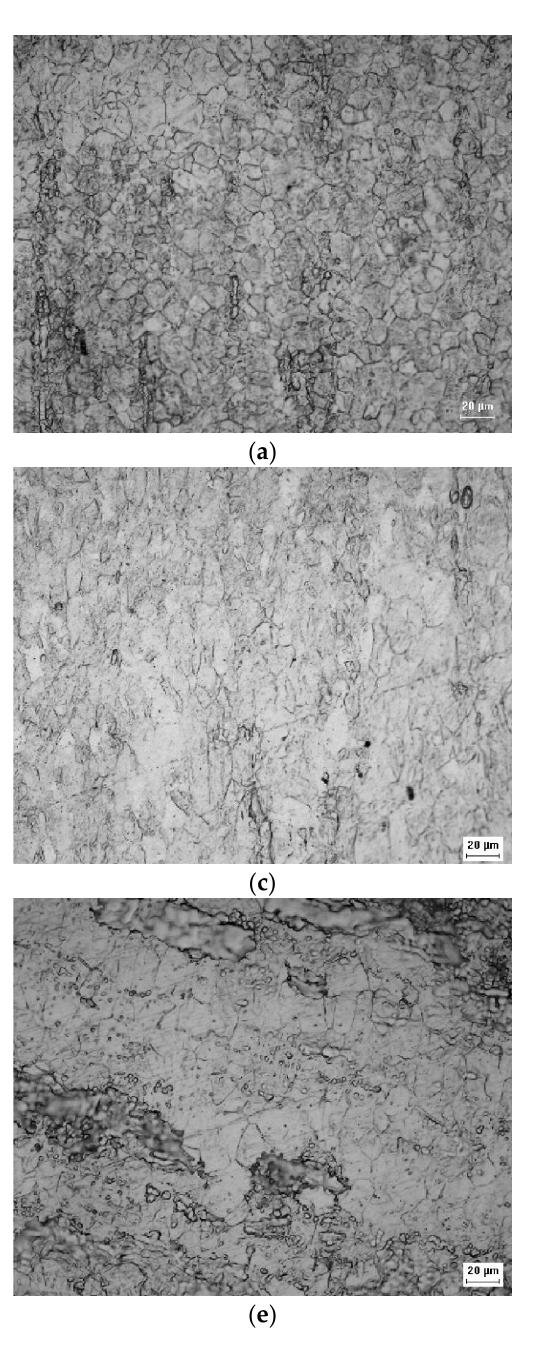
Figure 2. Micrograph of the A0 ( a ), A1 ( b ), A2 ( c ), B0 ( d ), B1 ( e ), and B2 ( f ) samples acquired by optical microscopy with ×500 magnification showing the appearance of austenitic grains after electrolytic attack.